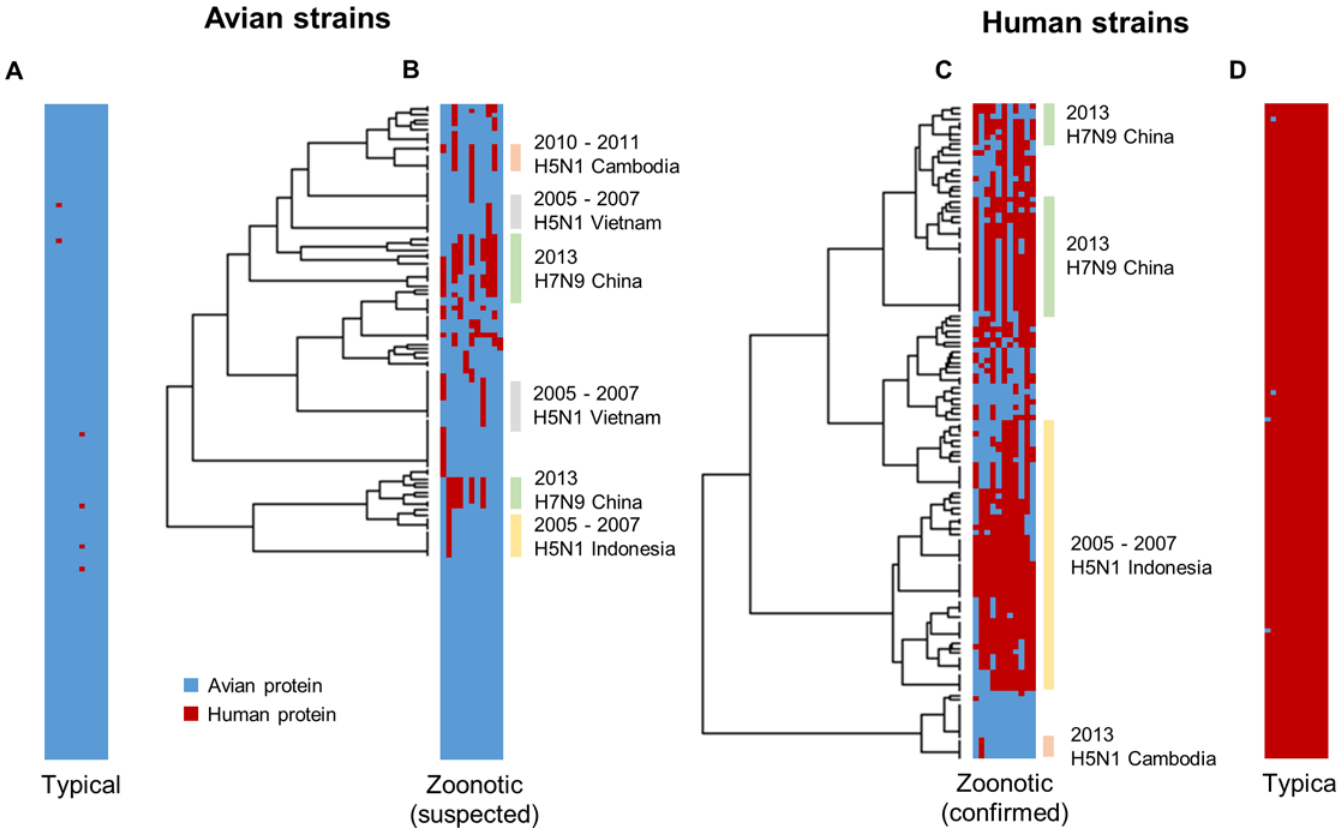
Fig 1. Host tropism protein signatures of avian, human and zoonotic strains. Each row in the bar represents a strain, with 11 columns depicting one of each protein prediction (HA, M1, M2, NA, NP, NS1, NS2, PA, PB1, PB1-F2, and PB2). Blue column indicates an avian protein prediction while red column indicates a human protein prediction. Only a total of 146 strains are shown in each bar to match the low number of samples in confirmed zoonotic strains, with the complete result landscape illustrated in S1 Fig. (A) Typical avian strains show almost exclusive avian predictions. (B) Suspected zoonotic strains isolated from avian species during zoonotic outbreaks show slight mosaic patterns of mixed avian and human predictions. (C) Confirmed zoonotic strains isolated from human patients during zoonotic outbreaks display prominent mosaic patterns. (D) Typical human strains with almost exclusive human predictions. Hierarchical clustering shows that zoonotic strains from the same outbreaks tend to have similar signatures, with the bars indicating strains from the zoonotic outbreaks.